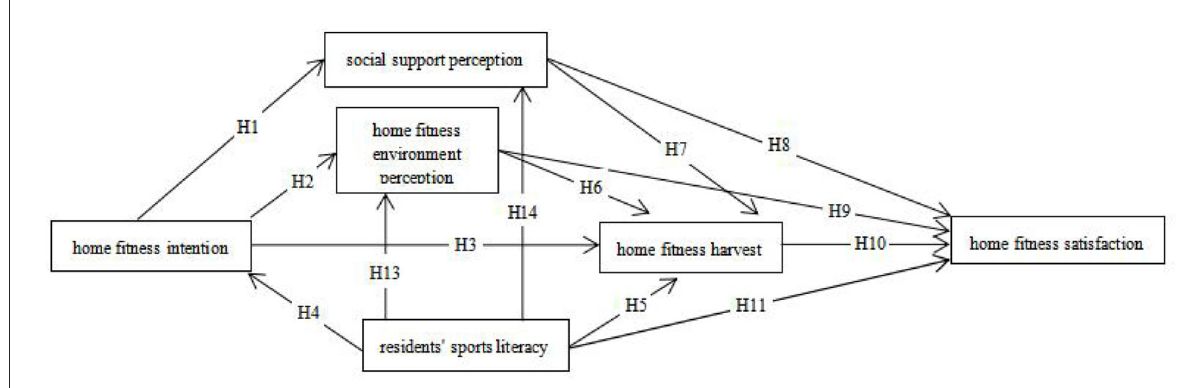
FIGURE2 Modified model of residents’ satisfaction with home fitness.